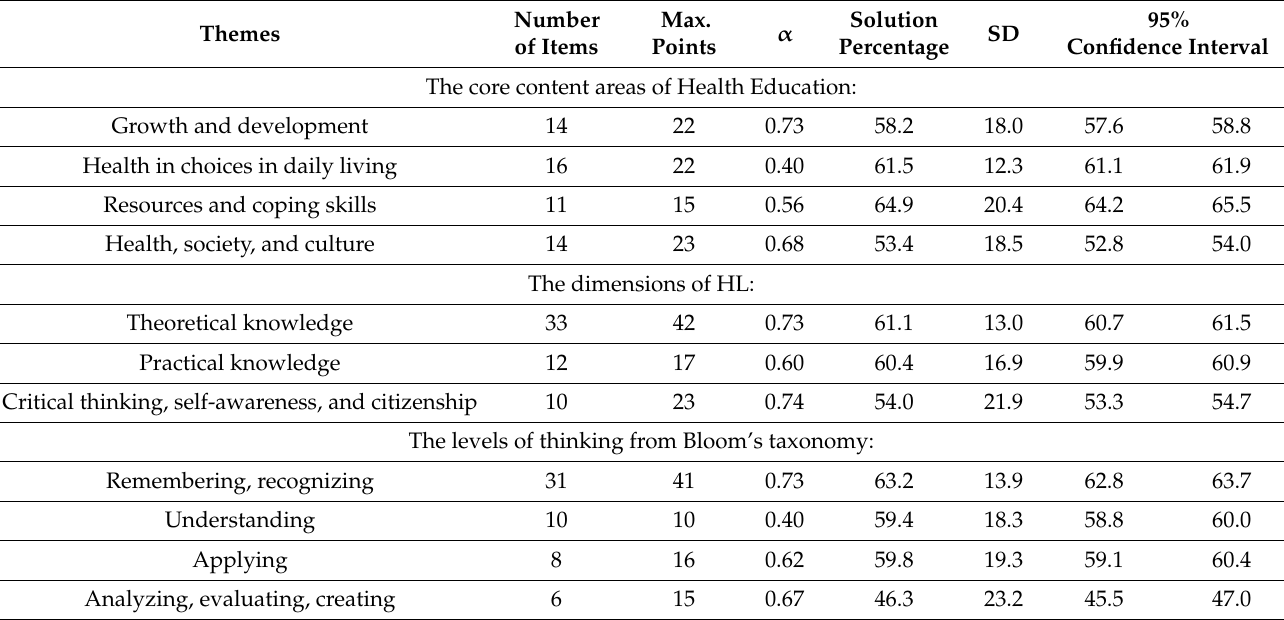
Table 1. Descriptive statistics for the main study items.